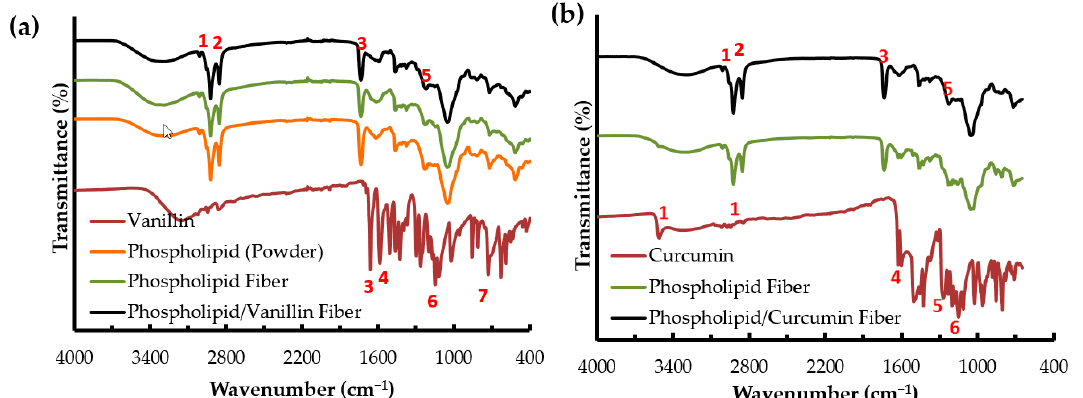
Figure 2. FTIR spectra of vanillin powder, asolectin powder, electrospun asolectin fiber and electrospun asolectin/vanillin fiber prepared using limonene ( a ) and curcumin powder, electrospun asolectin fiber and electrospun asolectin/curcumin fiber prepared using isooctane ( b ) as solvents. The red numbers